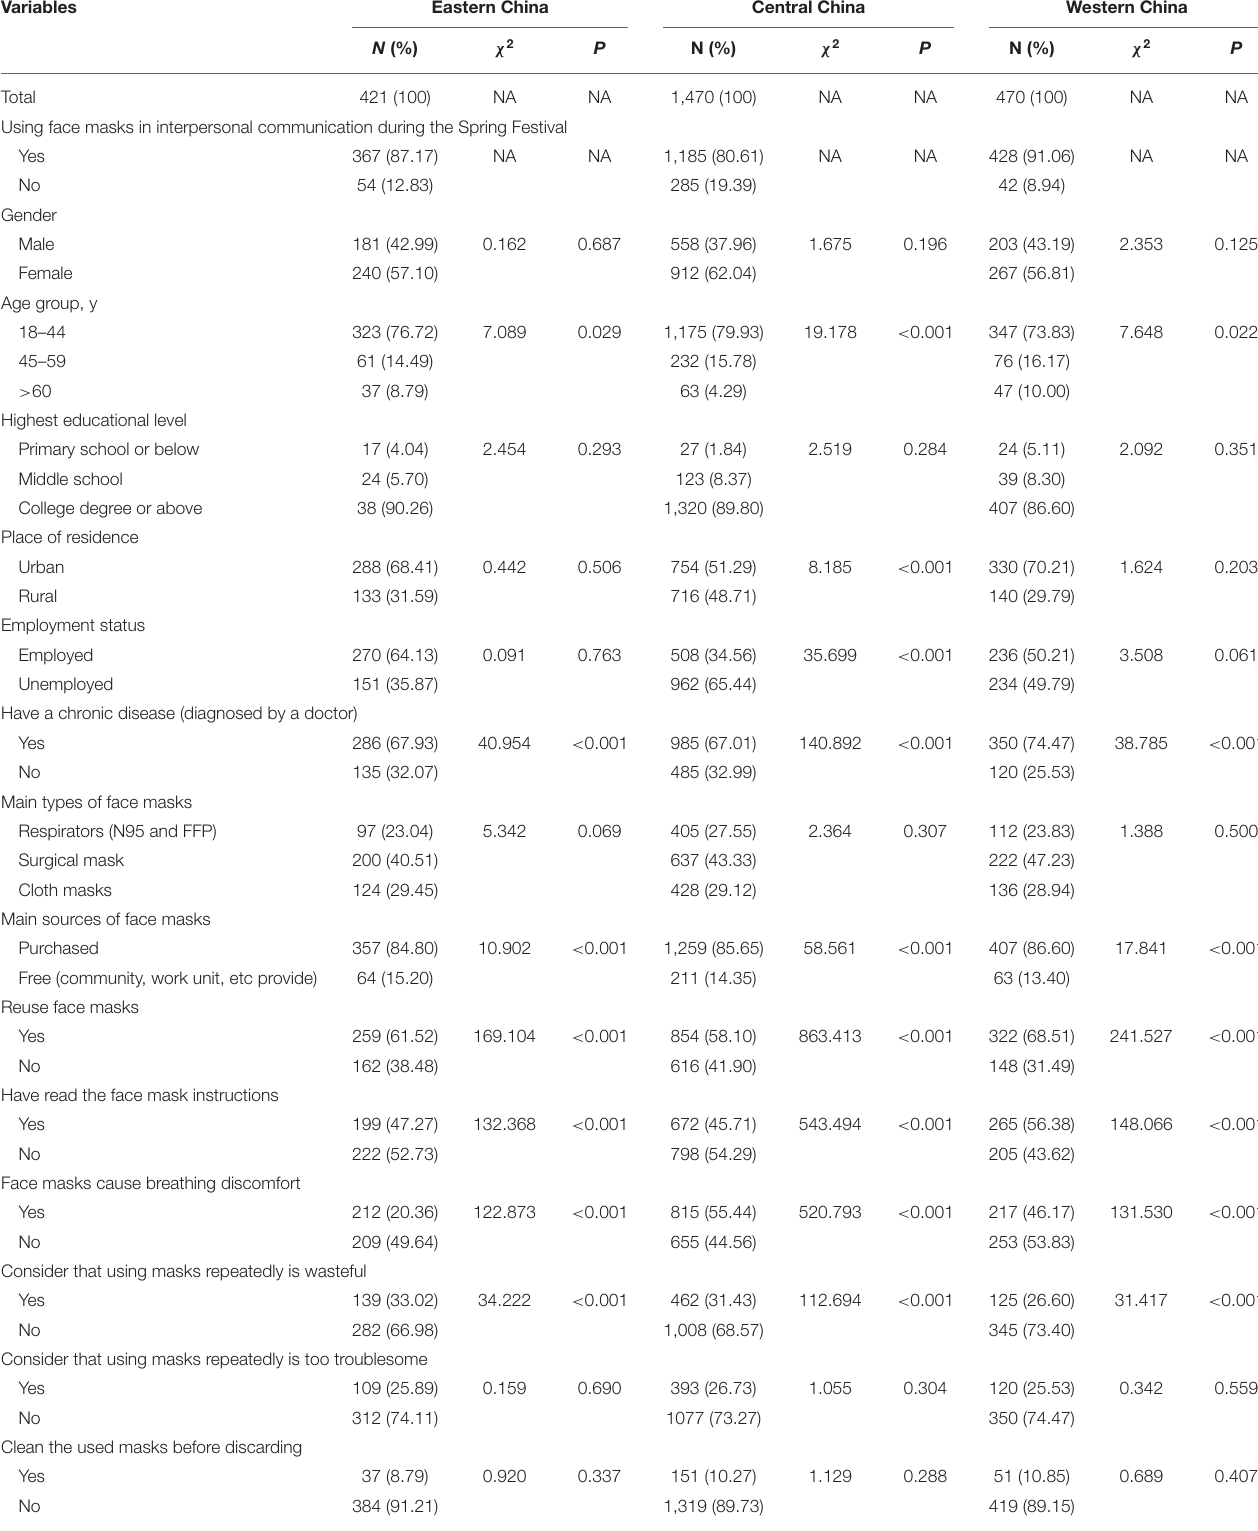
TABLE 2 | Univariate analysis of the differences in the willingness to use face masks in interpersonal communication during the Spring Festival among the included residents stratified by geographic characteristics. Variables Eastern China Central China Western